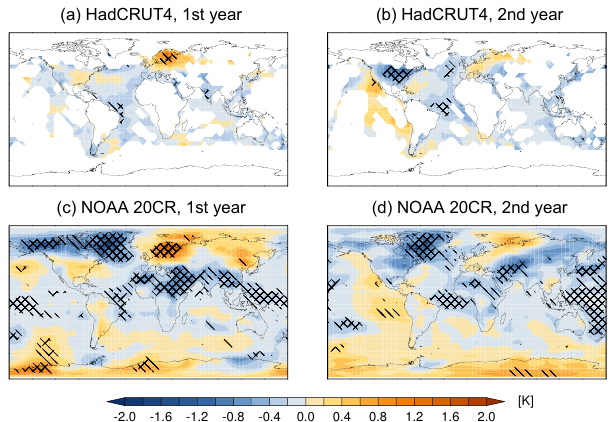
Figure 7. As Fig. 6 but for just HadCRUT4 data in panels (a, b) averaged over at least four of five eruptions and NOAA-20CR data without missing data consideration, averaged over all 5 post- volcanic